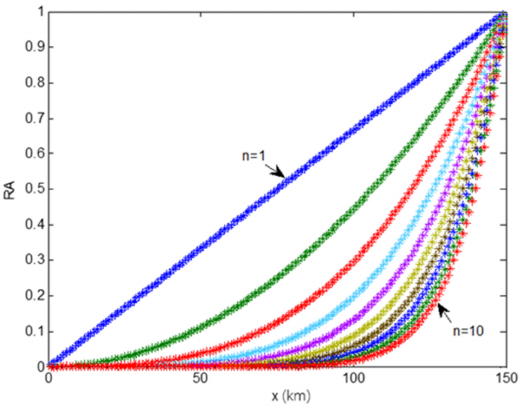
Figure 1. The plot of RA ( x ) at Q = 150, n = 1, . . . ,